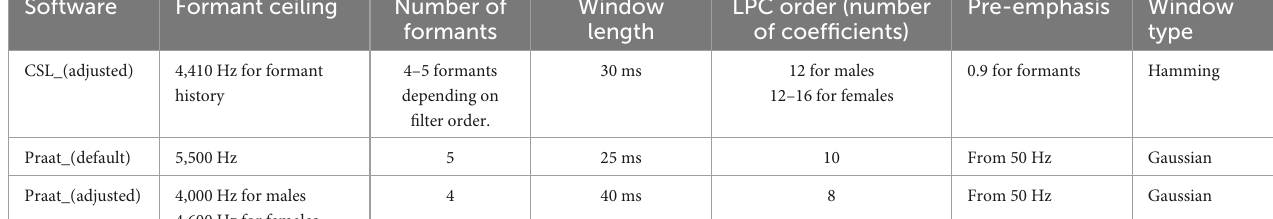
TABLE 1 The settings of Computerized Speech Lab (CSL) and Praat used for formant analyses in this study. Software